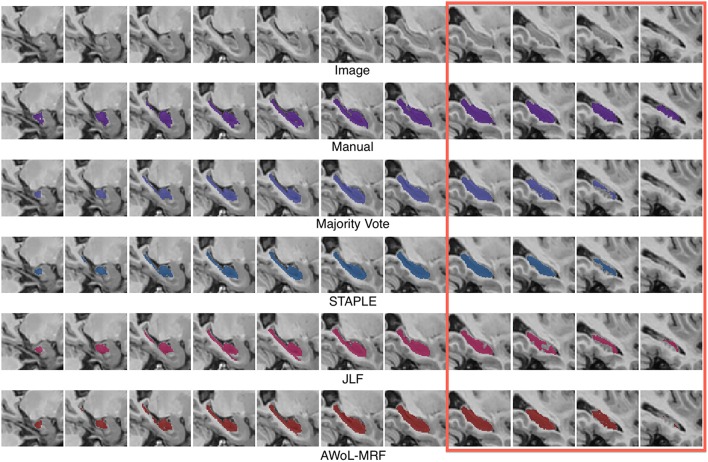
Experiment I Qualitative Analysis: Comparison of manual vs. automatic segmentation methods. The red rectangle illustrates a section where the superiority of the AWoL-MRF approach is particularly apparent. The segmentations are performed using 3 atlases, and the Dice scores are as follows: Majority Vote: 0.806 STAPLE: 0.833 JLF: 0.804 AWoL-MRF: 0.854. The segmentation of the left hippocampus is shown in sagittal view.